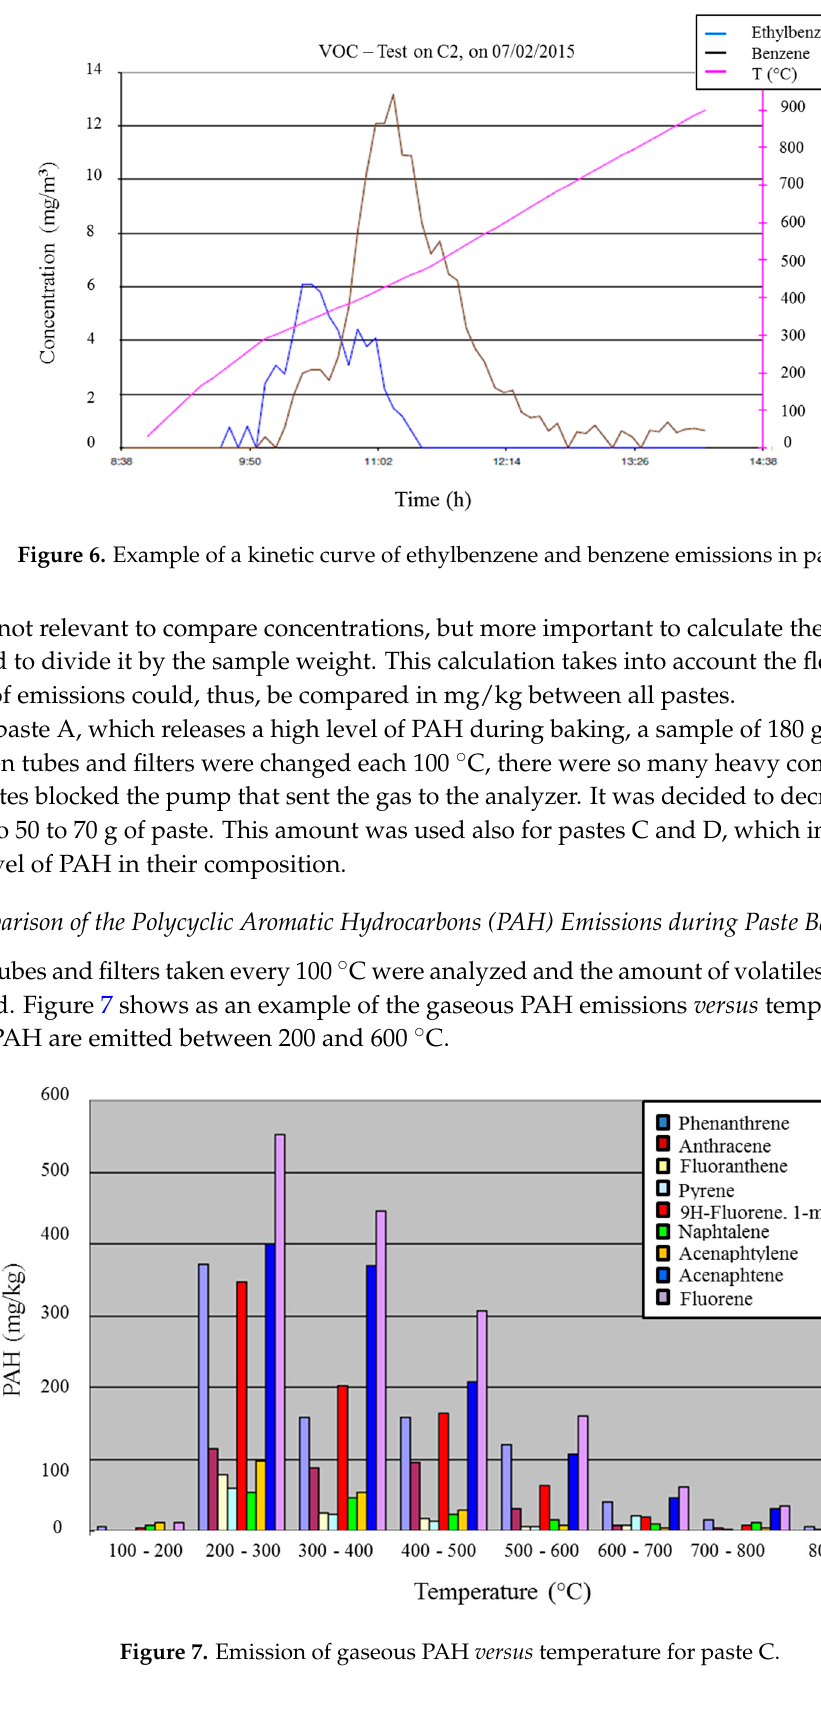
Table 10. PAH and ETF comparison. LD: Limit of detection. Component (mg/kg)